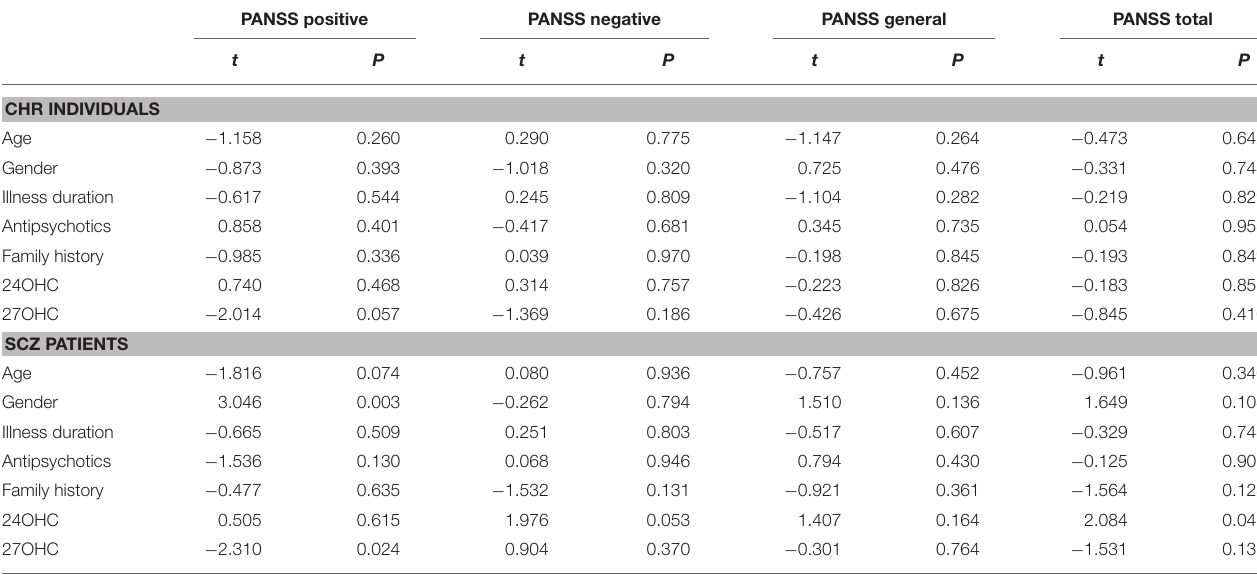
TABLE 3 | Associations between psychiatric symptoms and oxysterols levels in schizophrenia